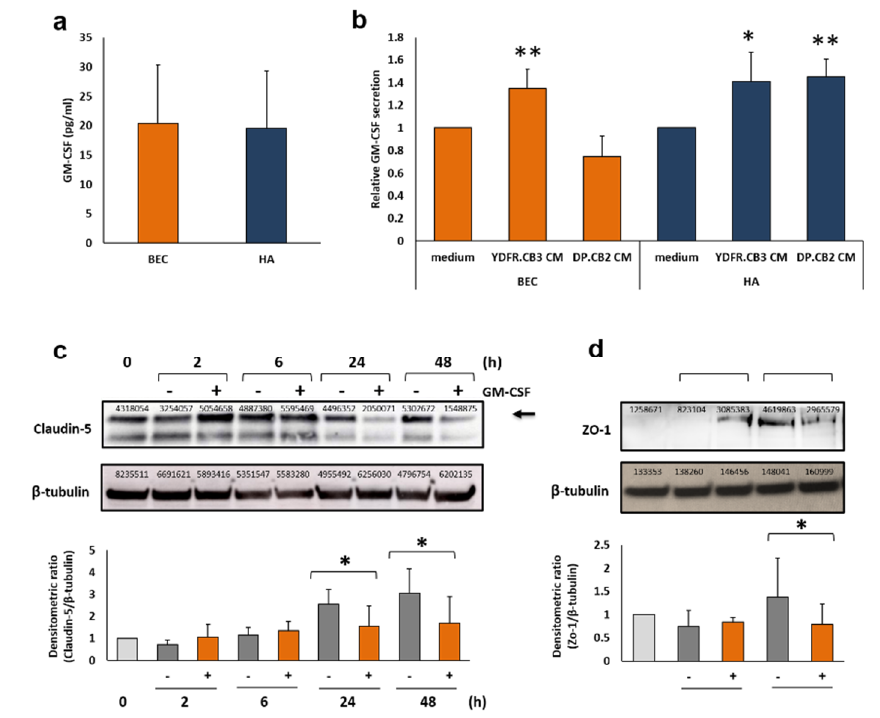
Figure 1. Melanoma-secreted factors stimulate granulocyte-monocyte colony stimulating factor (GM-CSF) secretion from brain endothelial cells (BEC) and astrocytes. Alteration of tight junction protein levels in BEC. ( a , b ) Extracellular levels of GM-CSF were determined by ELISA analysis. ( a ) 1 × 10 6 BEC or astrocytes (HA) were cultured for 24 h. The bars represent GM-CSF levels in 30-fold concentrated supernatants (pg / mL). ( b ) 1 × 10 6 BEC or astrocytes were treated with YDFR.CB3 or DP.CB2 CM for 4 h, then cultured in starvation medium for 20 h. Treatment with 0.5% FCS containing medium was used as control. The bars represent the relative GM-CSF levels normalized to control. All graphs represent an average of at least three independent experiments ± SD. * p < 0.05, ** p < 0.01. ( c ) BEC were stimulated with 30 ng / mL rhGM-CSF for 2, 6, 24 and 48 h ( + ). Control, untreated cells were grown in starvation medium for 0, 2, 6, 24 and 48 h ( − ). Western blot was applied to detect claudin-5 (23 kDa, marked with an arrow) and β -tubulin (55 kDa) for loading control in the cell culture lysates. Representative images are shown. ( d ) BEC were stimulated with 30 ng / mL rhGM-CSF for 2 and 6 h ( + ). Control, untreated cells were grown in starvation medium for 0, 2 and 6 h ( − ). Western blot was applied to detect ZO-1 (220 kDa) and β -tubulin in the cell culture lysates. Representative images are shown. The intensity of claudin-5 and ZO-1 signal was divided by the intensity of β -tubulin signal. The relative intensity was then normalized to t = 0. Graphs represent the average ± SD of at least three independents repeats. * p < 0.05.